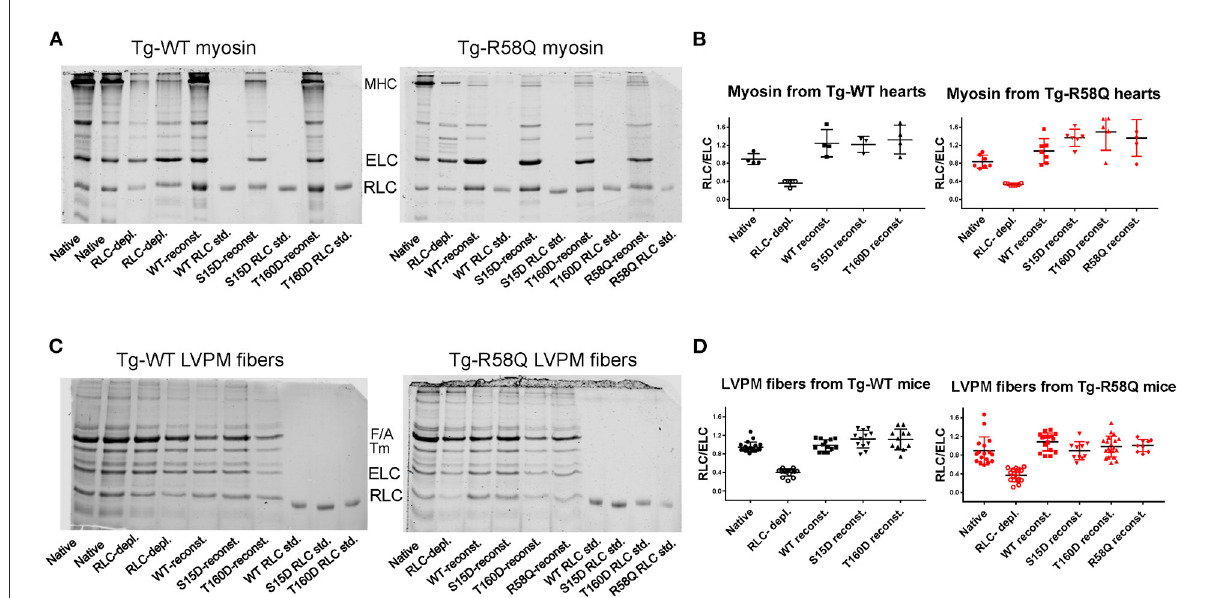
FIGURE2 Representative SDS-PAGE images of RLC-depleted and mutant-reconstituted cardiac muscle preparations from Tg-WT and Tg-R58Q mice. (A) Depletion and reconstitution experiments in mouse-purified cardiac myosin. (B) Myosin gels’ quantification. (C) Depletion and reconstitution experiments in LVPM fibers. (D) LVPM gels’ quantification. Cardiac preparations were CDTA/Triton-depleted of endogenous RLC and reconstituted with recombinant WT-RLC, R58Q, T160D, and S15D RLC proteins. Three to Four different myosin preparations from Tg-WT and 5–7 from Tg-R58Q mice were used to deplete 60 ± 6% endogenous RLC, followed by myosin reconstitution with recombinant RLC proteins at 140 ± 30% in Tg-WT and 155 ± 40% Tg-R58Q myosin (A,B) . Eleven to Twenty LVPM fibers from Tg-WT and 9–20 from Tg-R58Q mice were employed to deplete 60 ± 12% RLC from LVPM, followed by 112 ± 20% reconstitution with recombinant RLC proteins in Tg-WT and 106 ± 21% in Tg-R58Q LVPM fibers (C,D) . Data in (B,D) are presented as means ± SD.